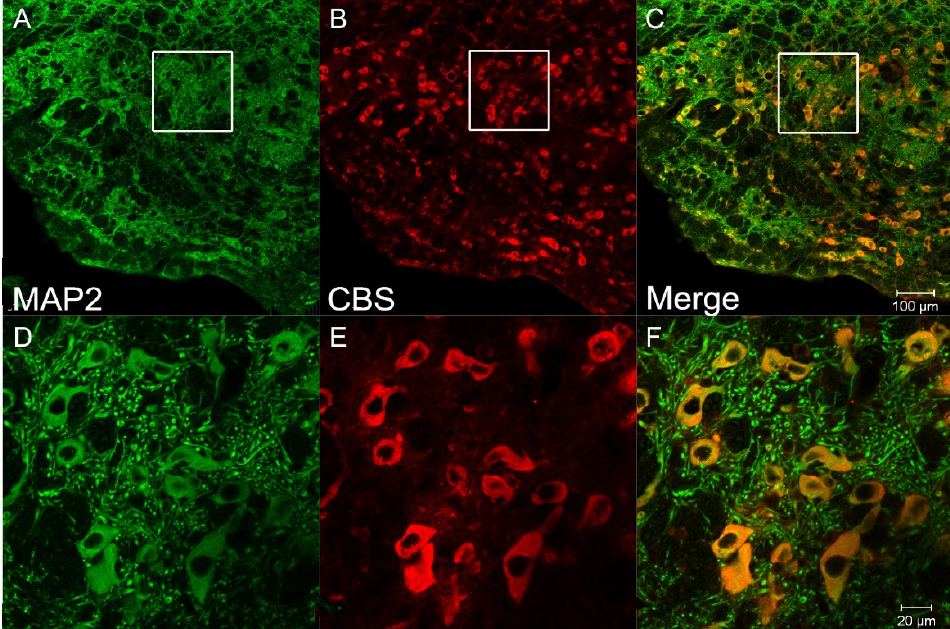
Figure 1. CBS expressed in the cytoplasm of RVLM neurons. Confocal images showed that CBS immunoreactivity (showed in red, ( B , E )) is co-localized with a neuronal marker (MAP2 showed in green, ( A , D )). Figure ( C , F ) represents the overlay image. All nuclei are stained with DAPI. Bars = 100 µ m ( A – C ). Bars = 20 µ m ( D – F ).